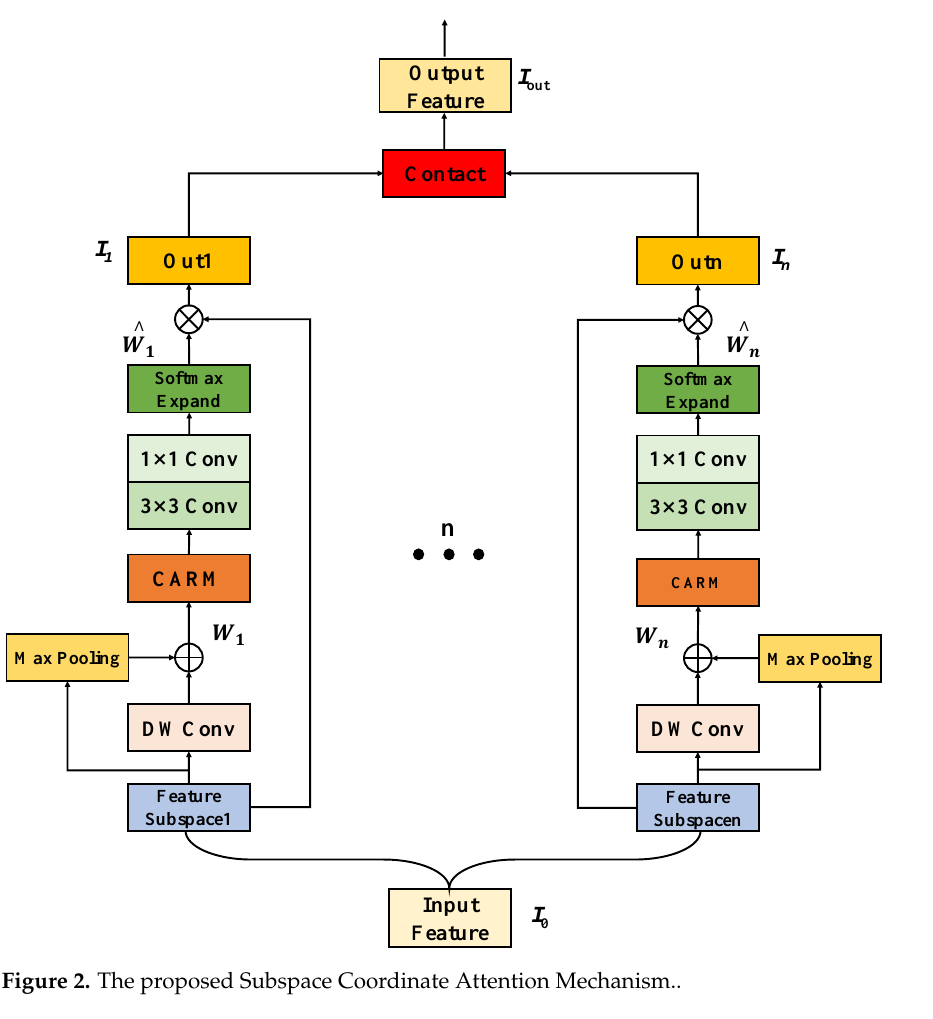
Figure 2. The proposed Subspace Coordinate Attention